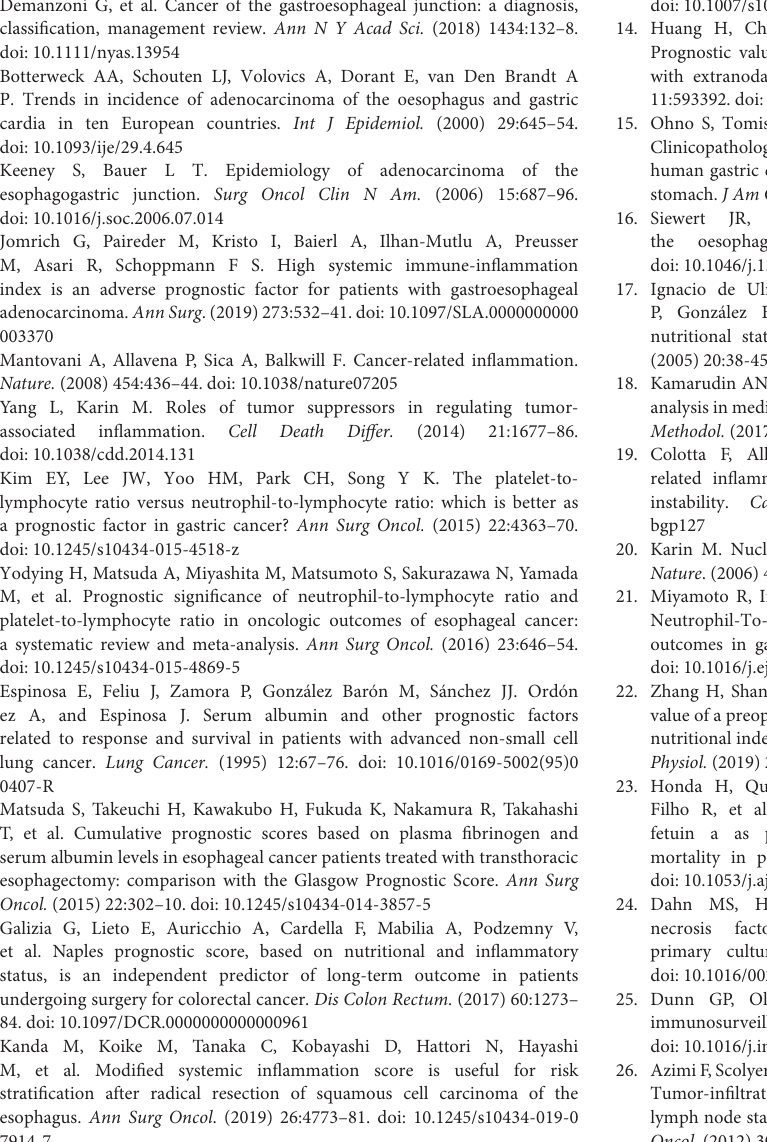
Supplementary Table 2 | The definition of CONUT. CONUT, controlling nutritional status; ALB, albumin; TLC, total lymphocyte; TC, total cholesterol. Supplementary Table 3 | Univariate and multivariate analysis of clinicopathologic variables in relation to OS in patients with AEJ. OS, and overall survival. AEG, adenocarcinoma of the gastroesophageal junction; BMI, body mass index; ASA, American Society of Anesthesiologists; COUNT, controlling nutritional status; mSIS, modified systemic inflammation score. Supplementary Table 4 | Univariate and multivariate analysis of clinicopathologic variables in relation to RFS in patients with AEJ. RFS, relapse-free survival; AEG, adenocarcinoma of the gastroesophageal junction; BMI, body mass index; ASA, American Society of Anesthesiologists; COUNT, controlling nutritional status; mSIS, modified systemic inflammation